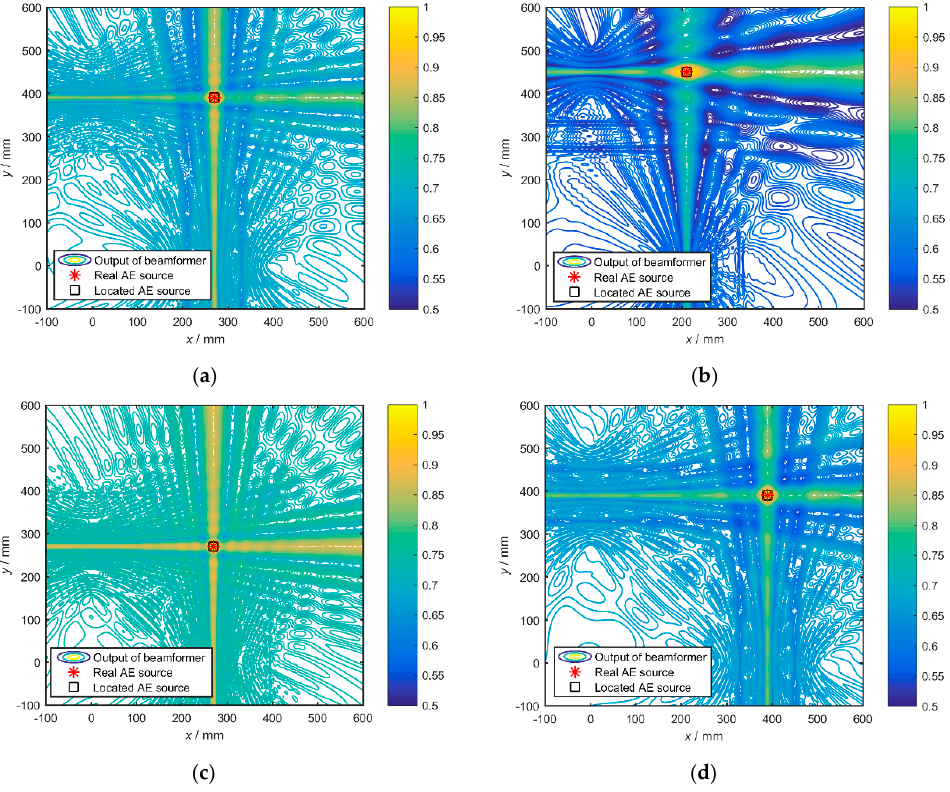
Figure 6. The localization results of four sets of AE sources: ( a ) Set 1; ( b ) Set 2; ( c ) Set 3; ( d ) Set 4.